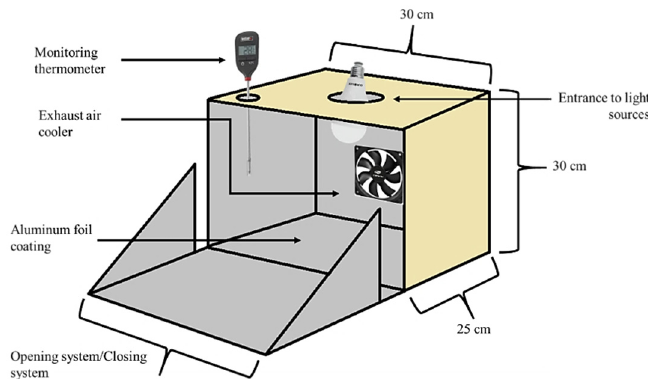
Figure 1. Scheme of the light irradiation box used to the light stability tests.